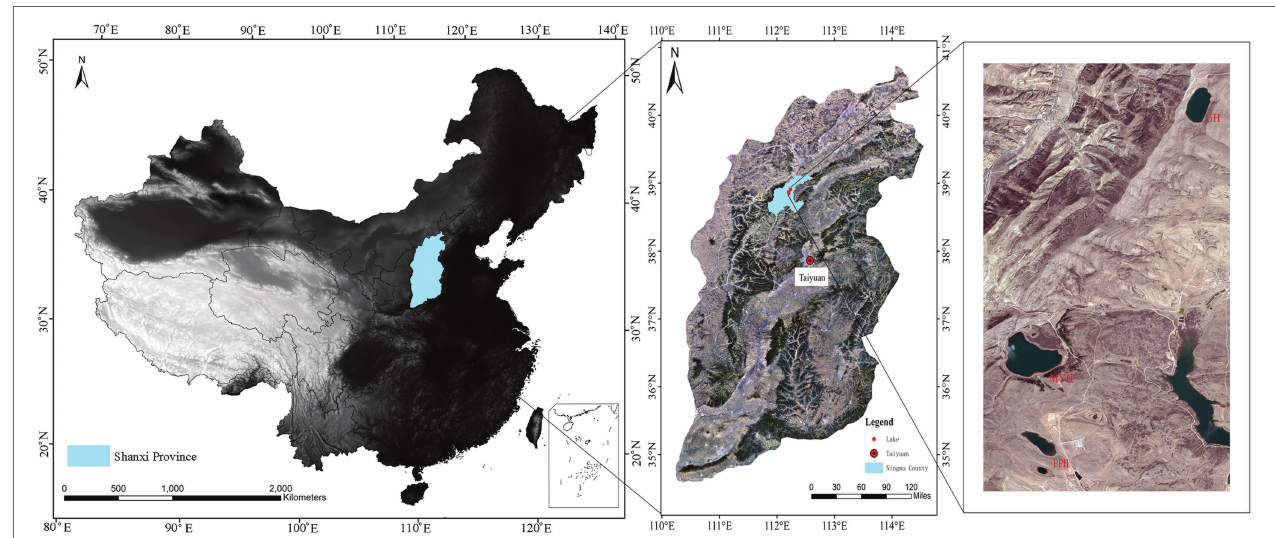
FIGURE 1 | Map showing the location of sampling sites and spatial distribution of Pipahai Lake (PPH), Mayinghai Lake (MYH), and Gonghai Lake (GH) in the Ningwu County of Shanxi, China.